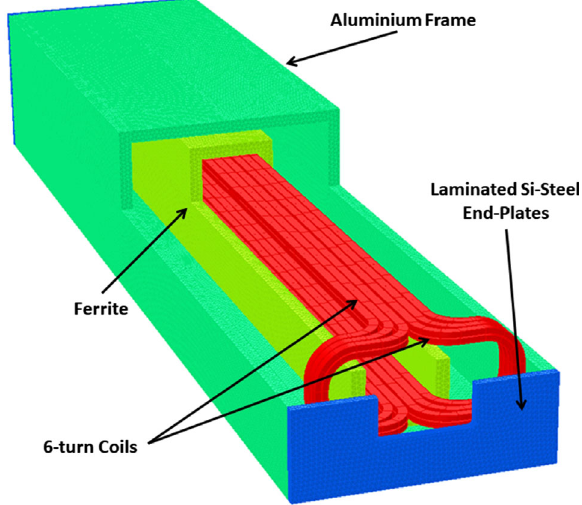
5. Geometry for a 3D simulation of the UCN kicker magnet. The overall length of the magnet, including end plates, is ∼ 1 . 71